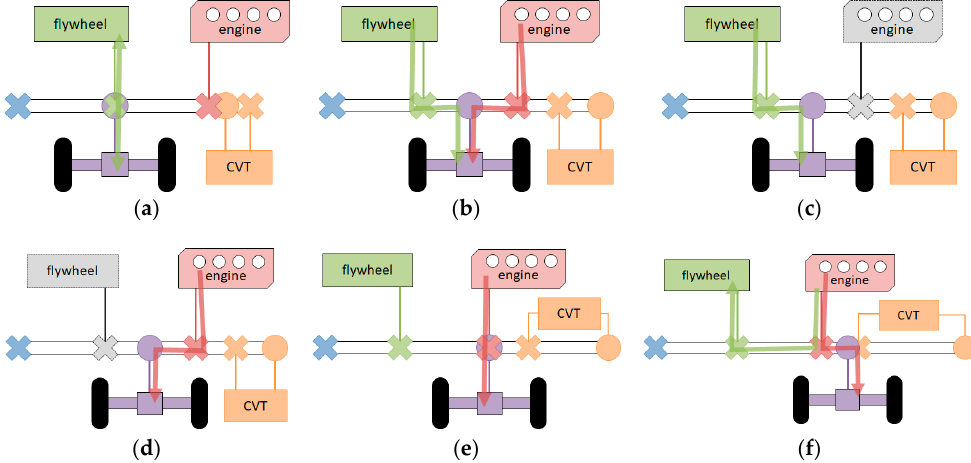
Figure 6. Power flow path of ( a ) flywheel drive/engine neutral; ( b ) assist drive; ( c ) flywheel drive with engine of; ( d ) engine drive with flywheel off; ( e ) engine drive/flywheel neutral; and ( f ) recharge drive mode.